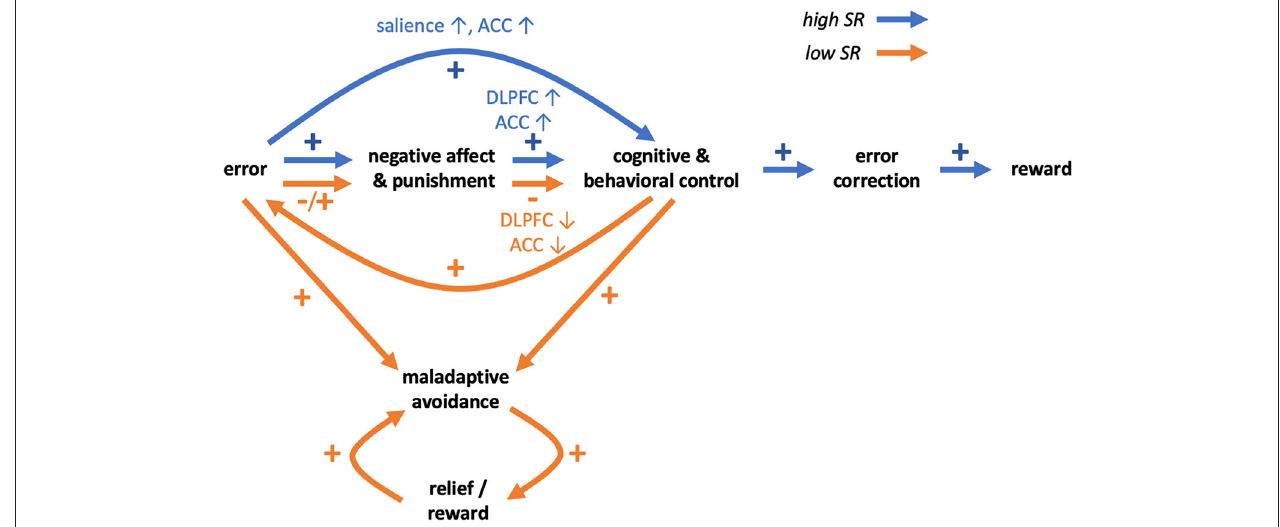
FIGURE 1 | Schematic hypothetical transdiagnostic model of self-regulation behaviors and disorders in relation to impaired coping and learning from errors and punishments. Differences between high SR (blue arrows) and low SR (orange arrows) individuals may involve brain reactions to negative affect and punishments. In individuals high in SR, negative affect and punishments may lead to increased activity of prefrontal control regions (ACC, DLPFC) and increased cognitive and behavioral control. In individuals low in SR, ACC and DLPFC activity in emotionally challenging situations may be relatively lower and result in impairment of cognitive and behavioral control. In individuals high in SR, errors may be processed as more salient events and lead to increased monitoring and control, supporting correction of errors in the future, leading to more rewards and learning of self-regulation. In individuals low in SR, learning from errors and punishments may be impaired. Errors may be processed as less salient and aversive events and not result in increased monitoring and control, potentially leading to repeating of errors. Eventually however errors may result in punishments and negative affect and further decline of cognitive and behavioral control. Both because of error-processing and diminished control, individuals low in SR may preferentially engage in maladaptive behaviors. The behavioral pattern may be reinforced by the relief and rewarding value of substitute behaviors, eventually preventing individuals low in SR from learning